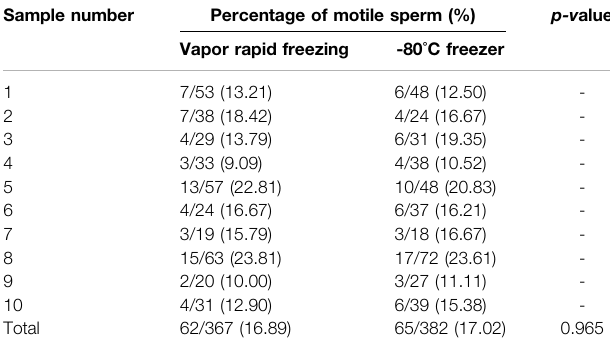
TABLE 5 | Motile sperm percentage of testicular sperm samples after cryopreservation with vapor rapid freezing and -80 ° C freezer. Sample